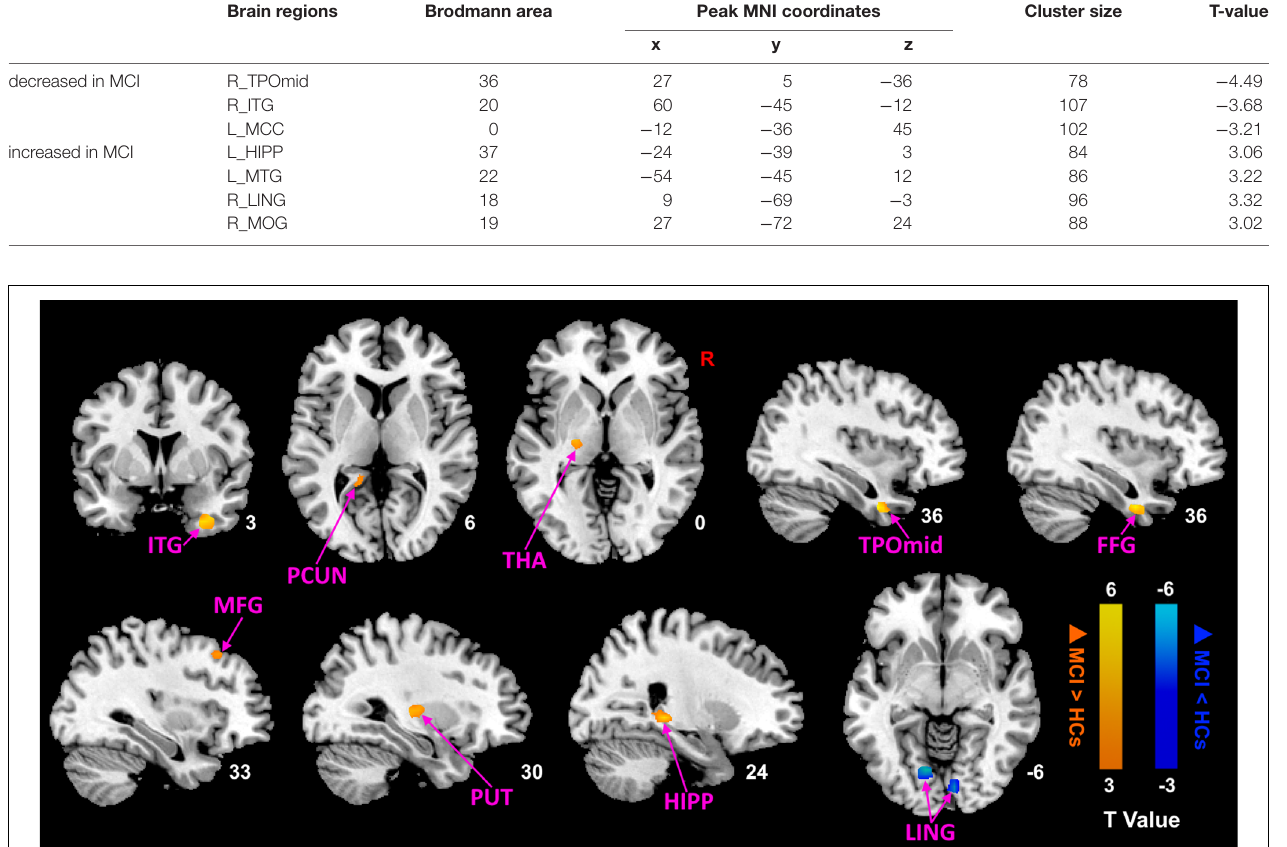
FIGURE 2 | ALFF analysis of MCI patients after moxibustion treatment ( p < 0.05, FDR correction). Warm color represents an increase and cool color represents a decrease respectively. ALFF, amplitude of low-frequency fluctuation; FDR, false discovery rate; ITG, inferior temporal gyrus; PCUN, precuneus; THA, thalamus; TPOmid, temporal poles: middle temporal gyrus; FFG, fusiform gyrus; MFG, middle frontal gyrus; PUT, putamen; HIPP, hippocampus; LING, lingual gyrus; MCI, mild cognitive impairment; HCs, healthy controls.